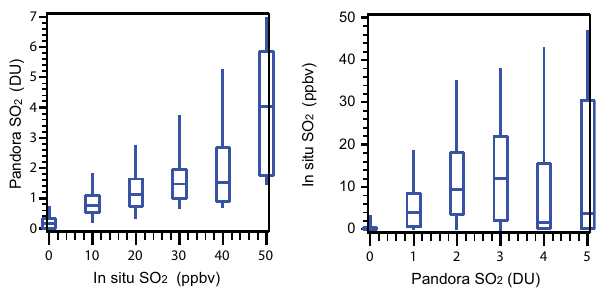
Figure 8. VCD and surface concentration SO 2 data binned by (left) surface concentration and (right) VCD values. Binned VCD and surface concentration data show a clear link between the two pa- rameters, but binning by Pandora’s values gives a different result from the binning by in situ data. When the surface concentration is elevated, vertical columns are also elevated. However, in about 25% cases, surface concentrations are close to zero even when the verti- cal column values are elevated. The bottom and top edges of the box are located at the sample 25th and 75th percentiles; the whiskers correspond to the 5th and 95th percentiles. The centre horizontal line is drawn at the